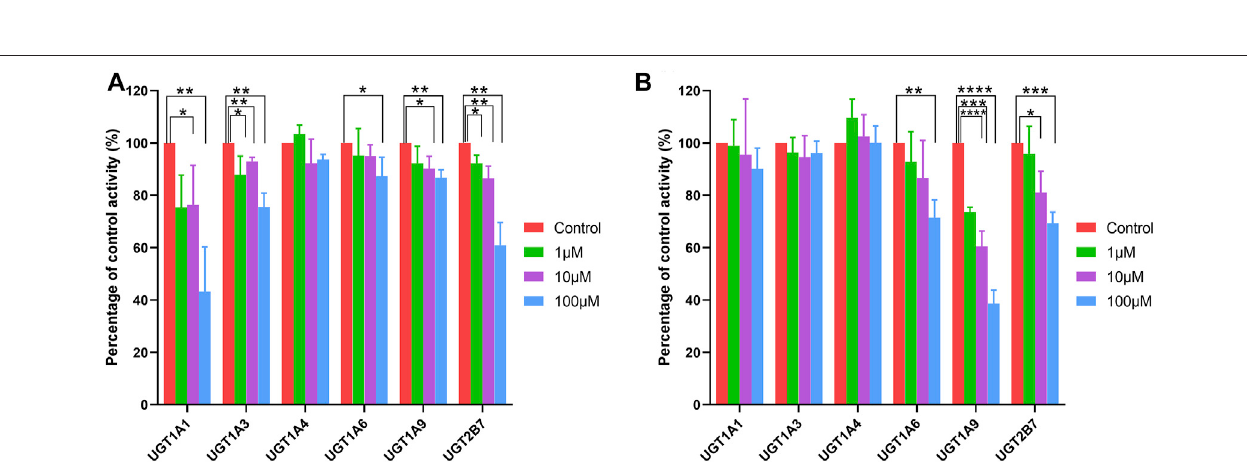
FIGURE 6 | Effects of ticagrelor (A) and ticagrelor-O-Glu (B) on the activities of human UGT enzymes. SN-38, chenodeoxycholic acid, tri fl uoperazine, N-Acetyl serotonin, mycophenolic acid, 3 ′ -azide-3 ′ -deoxythymidine were used as the probe substrates for UGT1A1, UGT1A3, UGT1A4, UGT1A6, UGT1A9 and UGT2B7, respectively. Each bar represents the mean ± S.D. of triple incubations. *, p < 0.05; **, p < 0.01; ***, p < 0.001, ****, p < 0.0001. Each bar represents the mean ± S.D. of triple incubations.